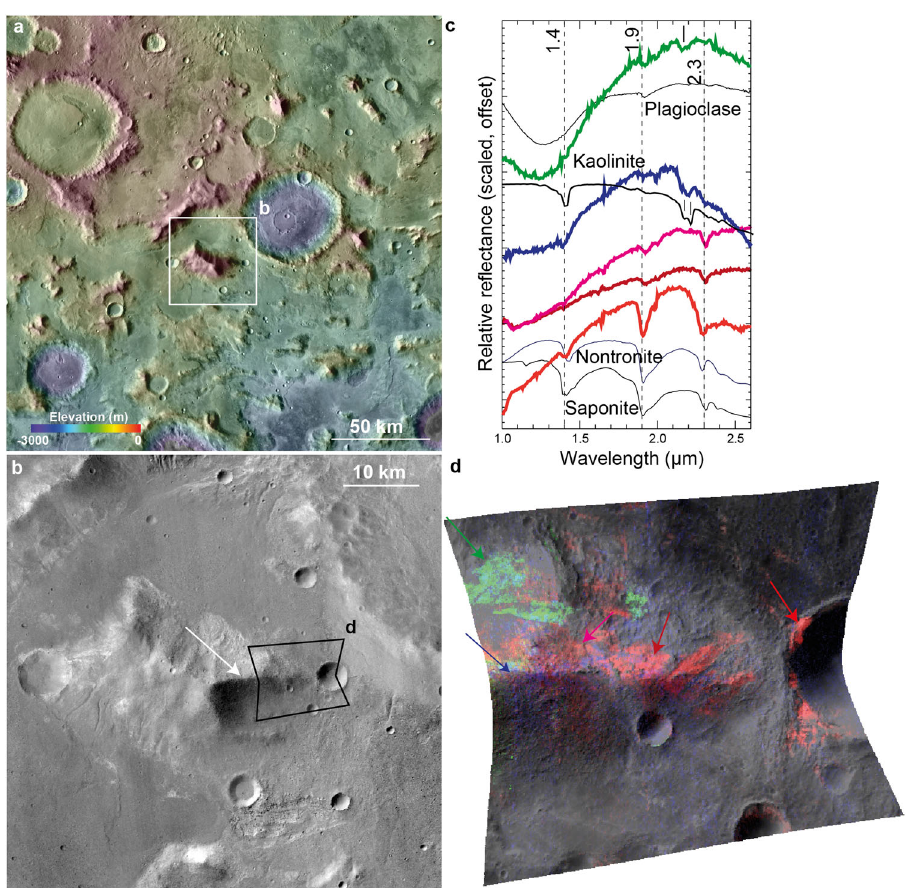
Fig. 3 Example of possible precipitation-driven chemical alteration of felsic materials. a The geology context of compositional stratigraphy on the massif of northern Hellas Planitia (66.32 2°E, 25.21°S). MOLA elevation data are draped over THEMIS daytime infrared data (warm colors are at higher elevations and cool colors are at lower elevations). b Close-up view of the massif indicates the location of compositional stratigraphy (white arrow). c Ratioed CRISM I/F spectra contain Al clay minerals, Fe/Mg smectites, and felsic materials. d CRISM mineral map shows the distribution of diverse altered minerals: Fe/ Mg smectites in red, felsic materials in green and Al clay minerals in blue. The different color arrows show the locations of spectra